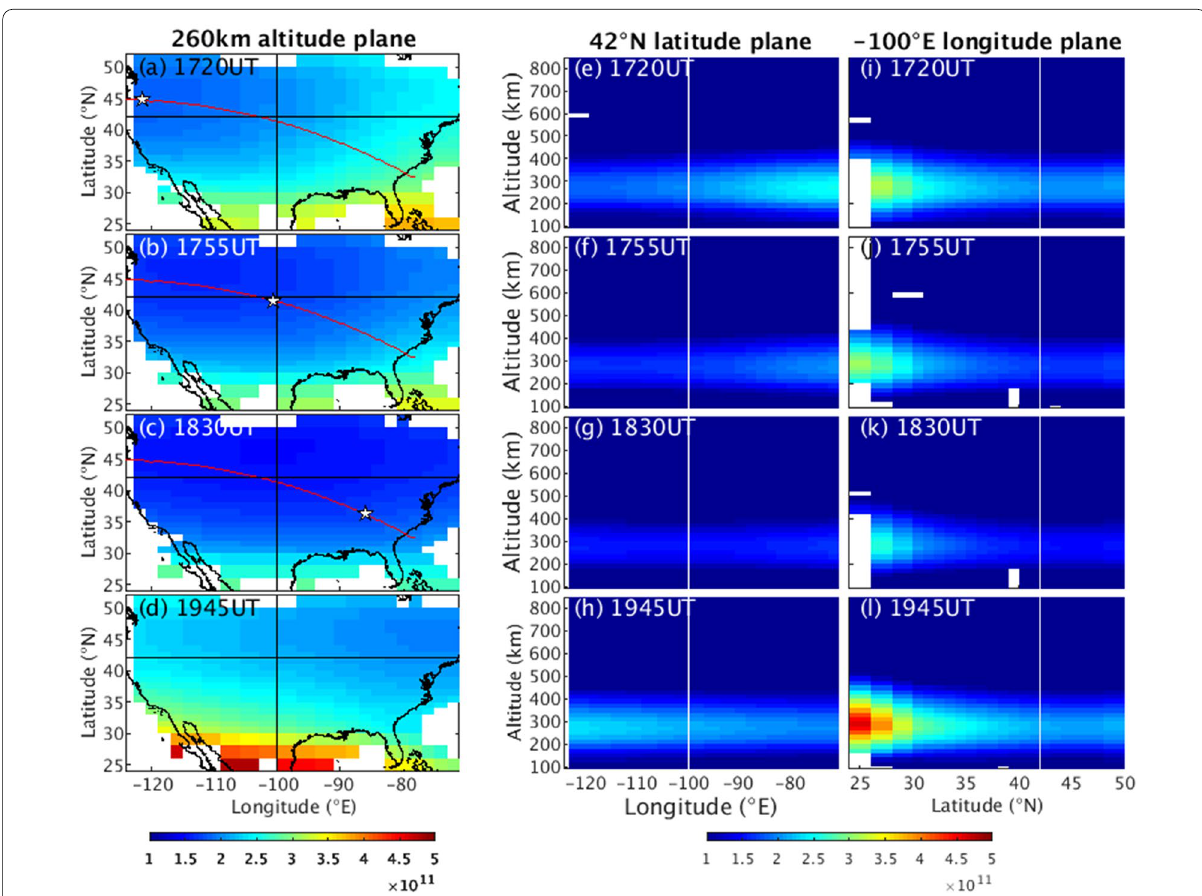
Fig. 2 The time variations of the reconstructed electron densities at 260 km altitude plane ( a – d ), 42 o N latitude plane ( e – h ), and plane ( i – l ). The red lines in a – c indicate the path of total eclipse. The white star is the location of maximum obscuration of solar